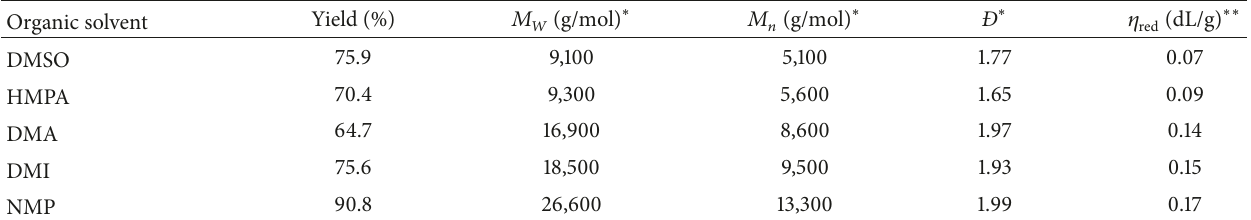
Table 3: The influence of the organic solvent on the characteristics of